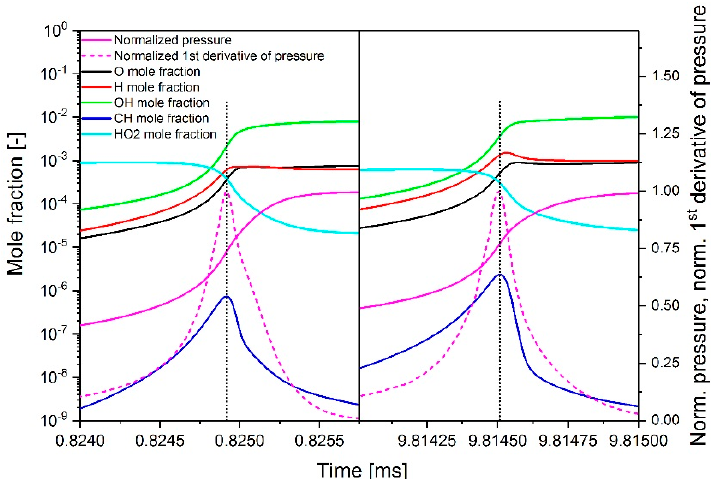
Figure 13. Simulated chronological mole fraction sequence of the species O, H, OH, CH and HO 2 as well as the pressure curve in the range of ignition of an n -heptane–air mixture at φ = 1, T = 750 K and p = 60 bar (left) and a methane–air mixture at φ = 1, T = 950 K and p = 60 bar (right) using a CV reactor.